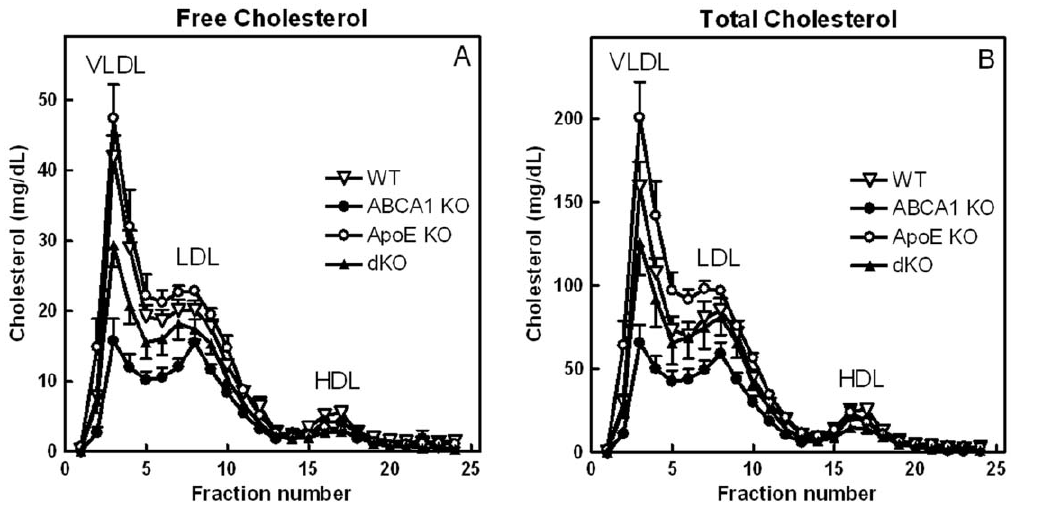
Figure 2. Lipoprotein profiles from ABCA1 and/or apoE KO transplanted LDLr KO mice and their WT transplanted controls. Fifty m L samples of serum, pooled from 2 mice per genotype, collected after 9 weeks of HF/HC feeding, were subjected to FPLC fractionation. Distribution of serum FC and TC over the fractions (25 m L) was determined enzymatically. Values represent the means of n $ 5 samples per group. 1 sample corresponds to pooled serum of 2